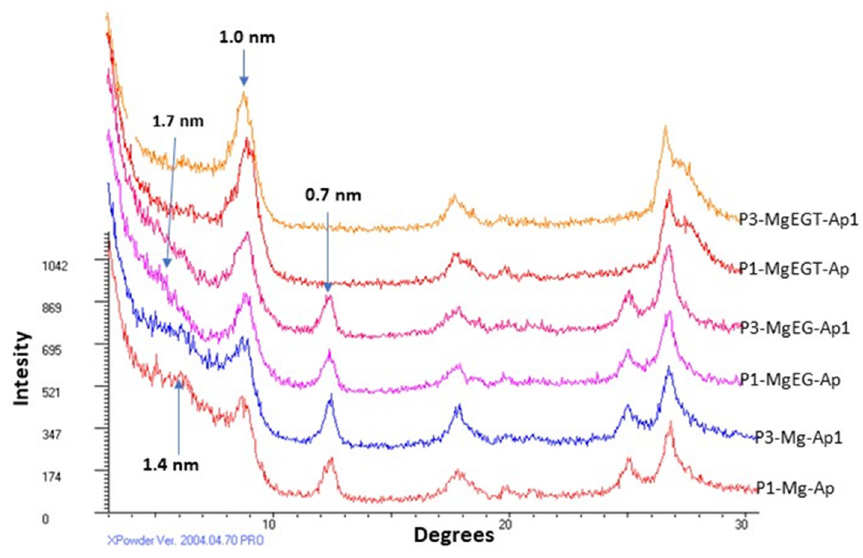
Figure 3. X-ray diffractogram comparing the clay mineralogies of horizon A of the P1 and P3 profiles for the different treatments. Mg: oriented aggregate saturated in magnesium; MgEG: oriented aggregate saturated in magnesium and ethylene glycol; MgEGT: oriented aggregate saturated in magnesium, ethylene glycol and thermal treatment (550 °C). Table 3. Cation exchange capacity (CEC), available elements (Na, K, Mg), and phosphorus (P).